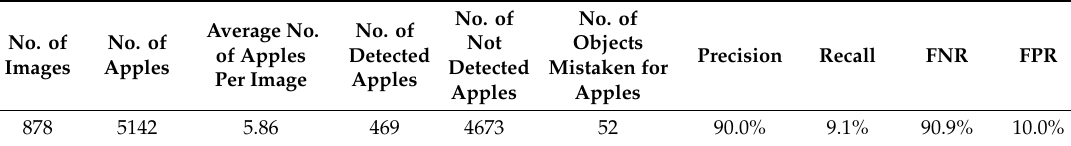
FNR: False Negative Rate; FPR: False Positive Rate.